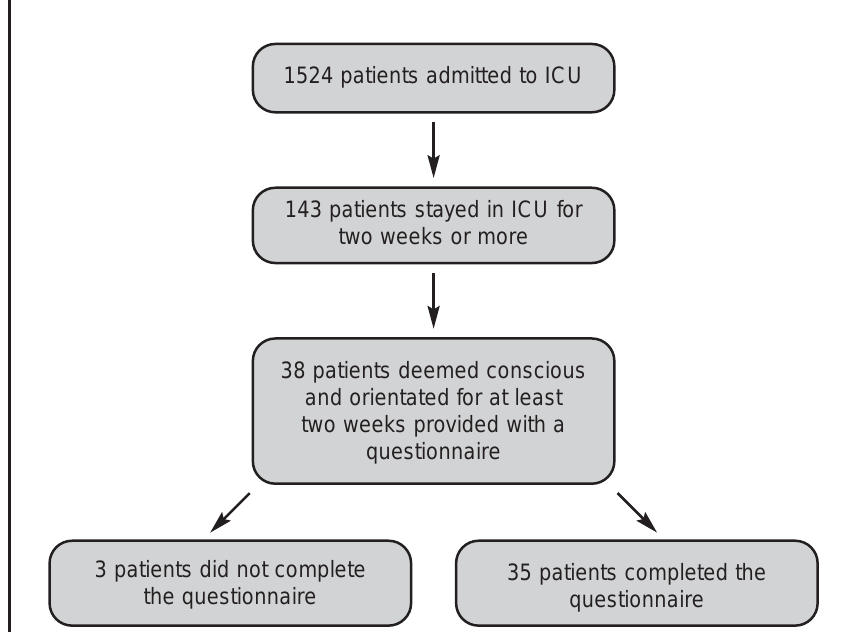
Figure1: Screening process for inclusion in the